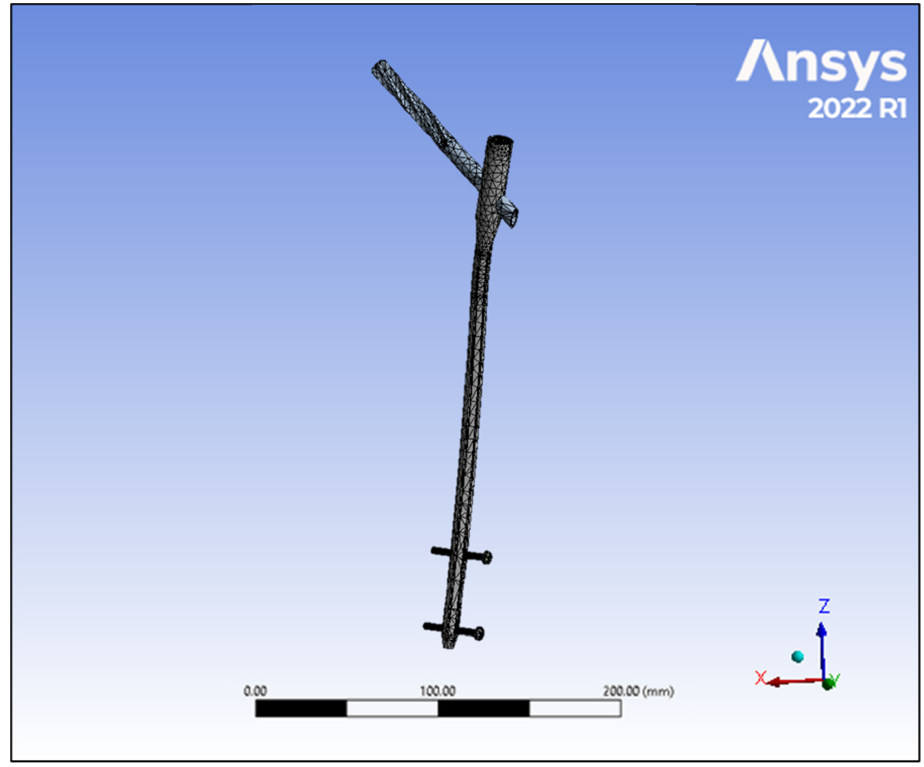
Figure 6. The 3D model of the femoral CM nail, the helical screw, and the two cortical screws show ‐ ing the meshing. the